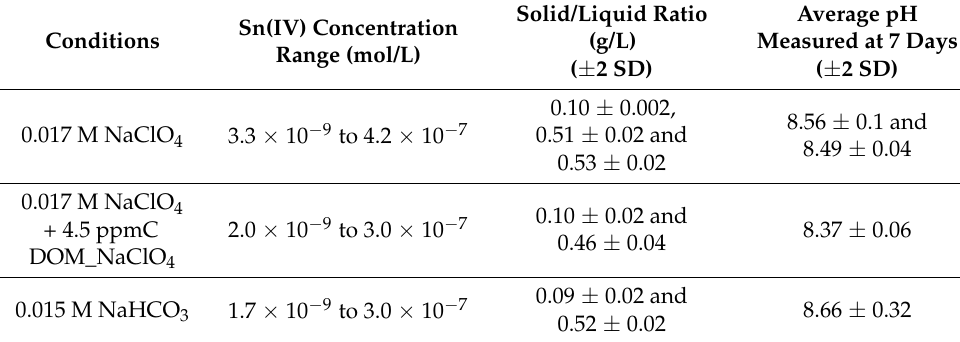
Table 2. Experimental conditions for Sn(IV) sorption isotherms on illite (IdP). Sn(IV) concentration corresponds to the concentration introduced at the start of the